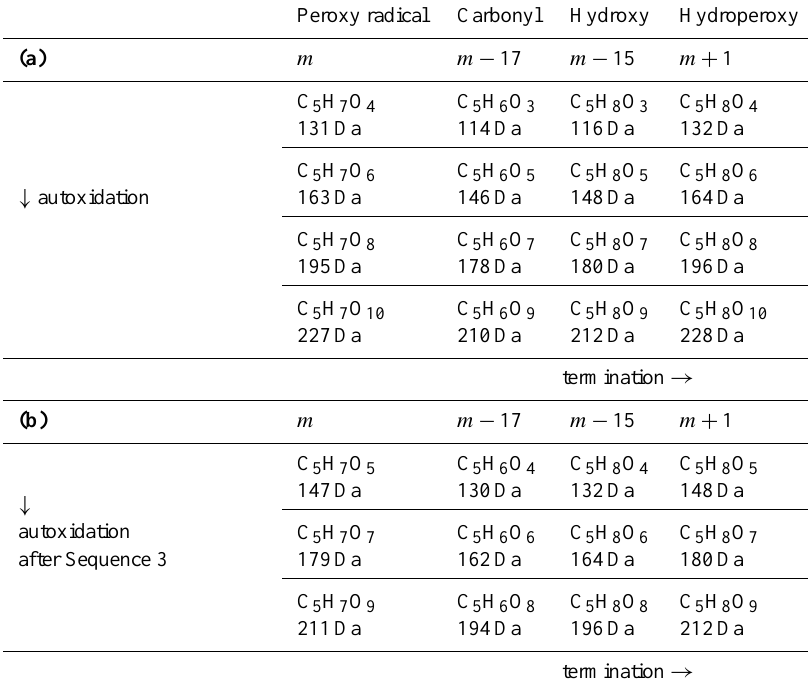
Table 2. (a) Possible peroxy radicals from cyclopentene and products of their reactions with peroxy radicals (cf. Sequence 2). (b) Analogous scheme for the hydroxy–peroxy path. The first peroxy radical in (b) arise from the first peroxy radical in (a) by reaction with another peroxy radical (or